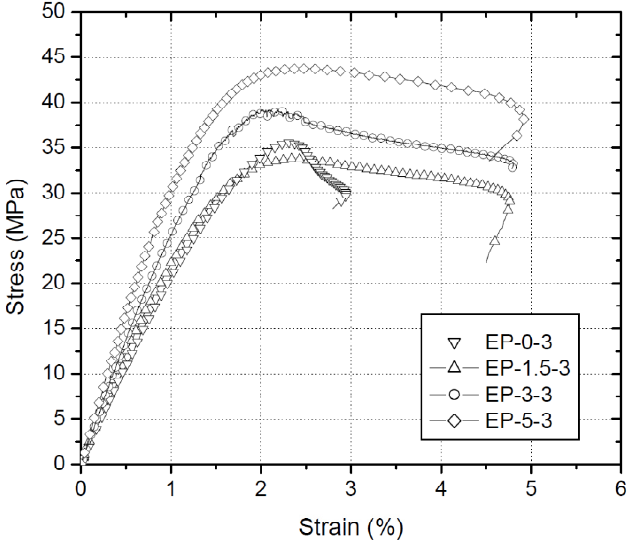
Figure 3. Stress-strain curves of typical original epoxy specimen (EP0-3) and enhanced epoxy specimens with different weight ratios of MCFs (EP1.5-3, EP3-3 and